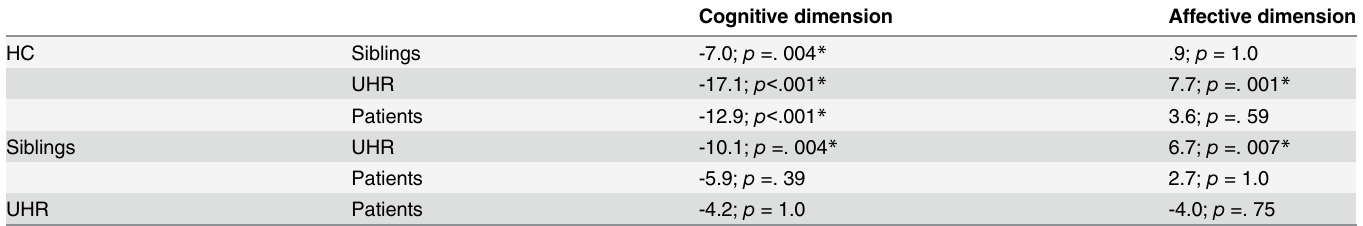
Cognitive dimension Affective dimension